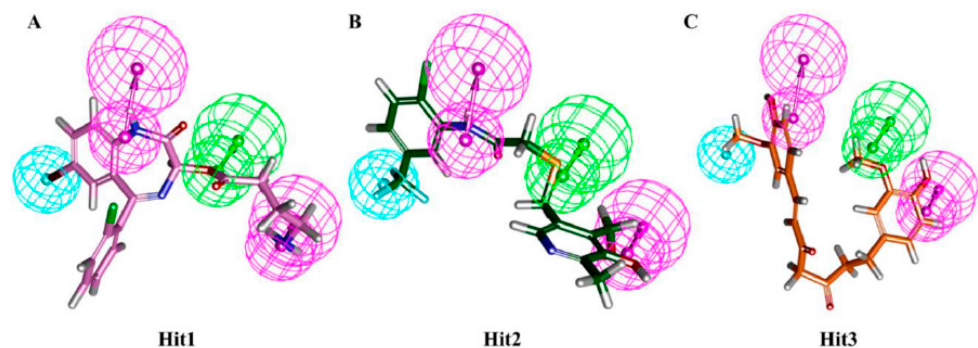
Figure 6. Alignment of Hypo1 and the final hit compounds. Hypo1 mapped all the features of Hit1 ( A ), Hit2 ( B ), and Hit3 ( C ). Hit compounds are represented as stick models.